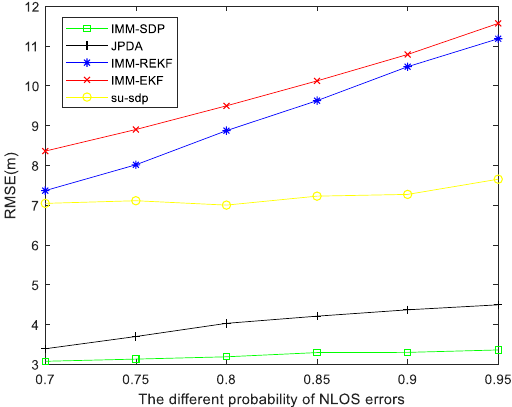
Figure 5. RMSE versus the standard deviation of NLOS errors.